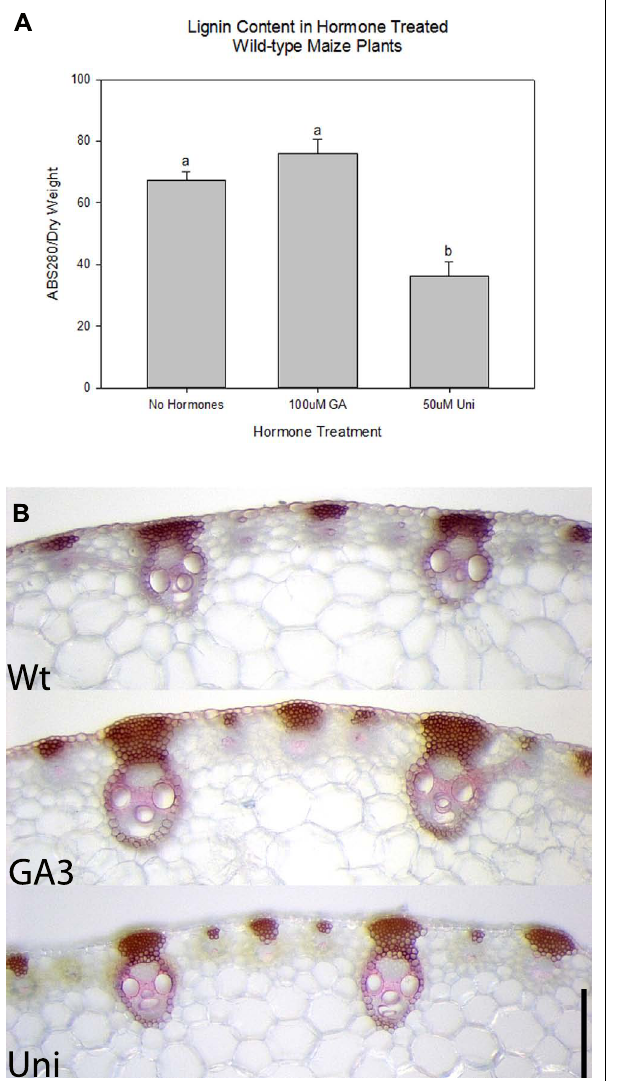
FIGURE 5 | Effects of gibberellic acid (GA3) and GA biosynthesis inhibitor uniconazole (Uni) in maize wild-type plants. (A) Relative lignin content in maize plants without hormone treatment and treated with GA3 and Uni. Error bars represent standard error ( ± SE; N = 4) where P < 0.050. (B) Phloroglucinol stained cross sections ofWt, GA3, and Uni treated maize stems. Scale bars = 0.25 mm (B) .